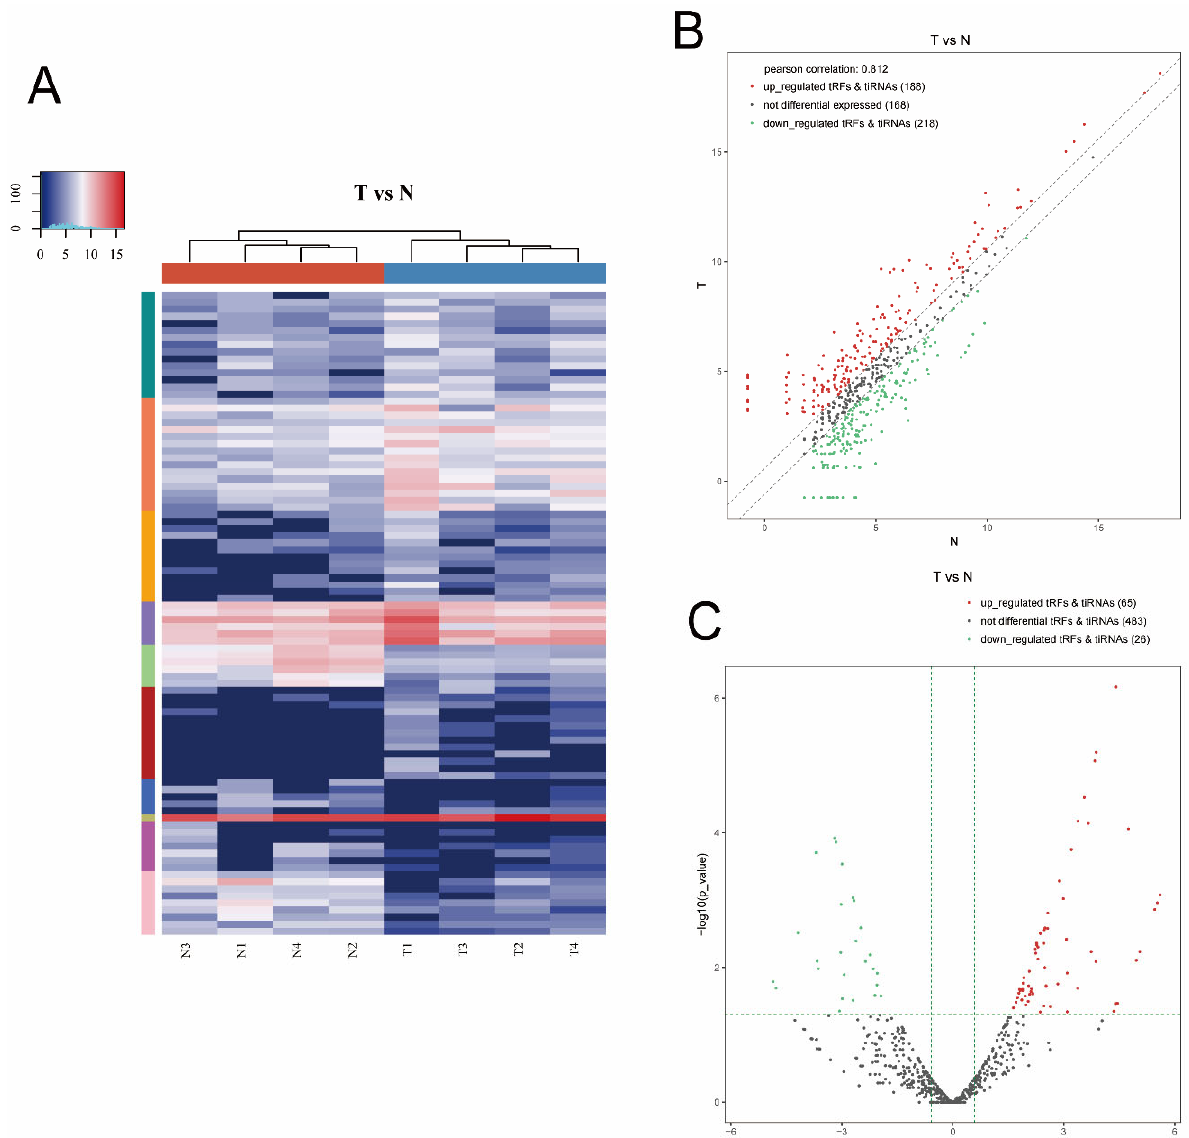
Figure 3. Hierarchical clustering and difference between the two groups (T vs. N). ( A ) The hierarchi- cal clustering heat-map for the tsRNAs. The color in the panel represents the relative expression level ( log2 -transformed). Blue represents an expression level below the mean, and red represents an expres- sion level above the mean. ( B ) The scatter plots of differentially expressed tsRNAs. tsRNAs above the top line (red dots, upregulation) or below the bottom line (green dots, downregulation) show more than 1.5-fold change between the two compared groups. Gray dots indicate nondifferentially expressed tsRNAs. ( C ) The volcano plots of significantly differentially expressed tsRNAs. The values of the X and Y axes in the volcano plot were log2 -transformed fold change and -log10-transformed p -values between the two groups, respectively. Red/green circles indicate statistically significant differentially expressed tsRNAs with a FC of no less than 1.5 and a p -value < 0.05 (red: upregulated; green: downregulated). Gray circles indicate nondifferentially expressed tsRNA with FC and/or q-value, which did not meet the cutoff